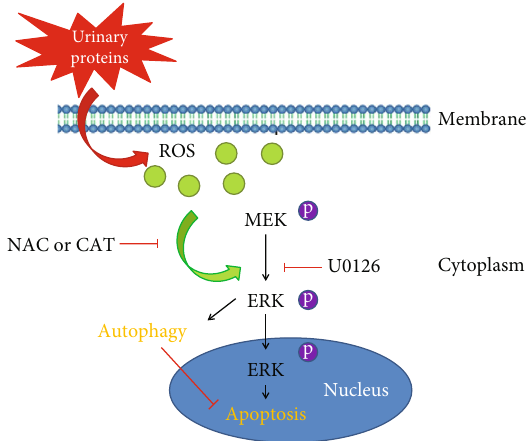
Figure 5: Schematic representation of the mechanisms of ROS-ERK pathway in urinary protein-induced injury in TECs. Urinary protein-induced ROS production triggers a cascade of phosphorylation reactions in the ERK pathway, which is a common mediator of protective autophagy and injury in TECs. In the early phase, cytoplasm p-ERK induces autophagy-associated adaptive response. Once stimulation is sustained, cytoplasm p- ERK transfers into the nucleus and elicits cell